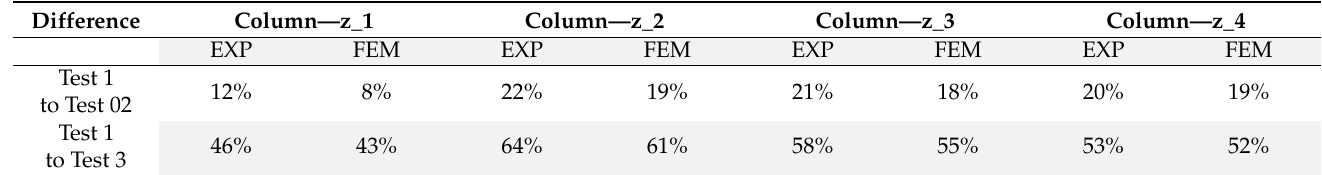
Table 3. Changes in column stiffness—axis load to the eccentricity of the